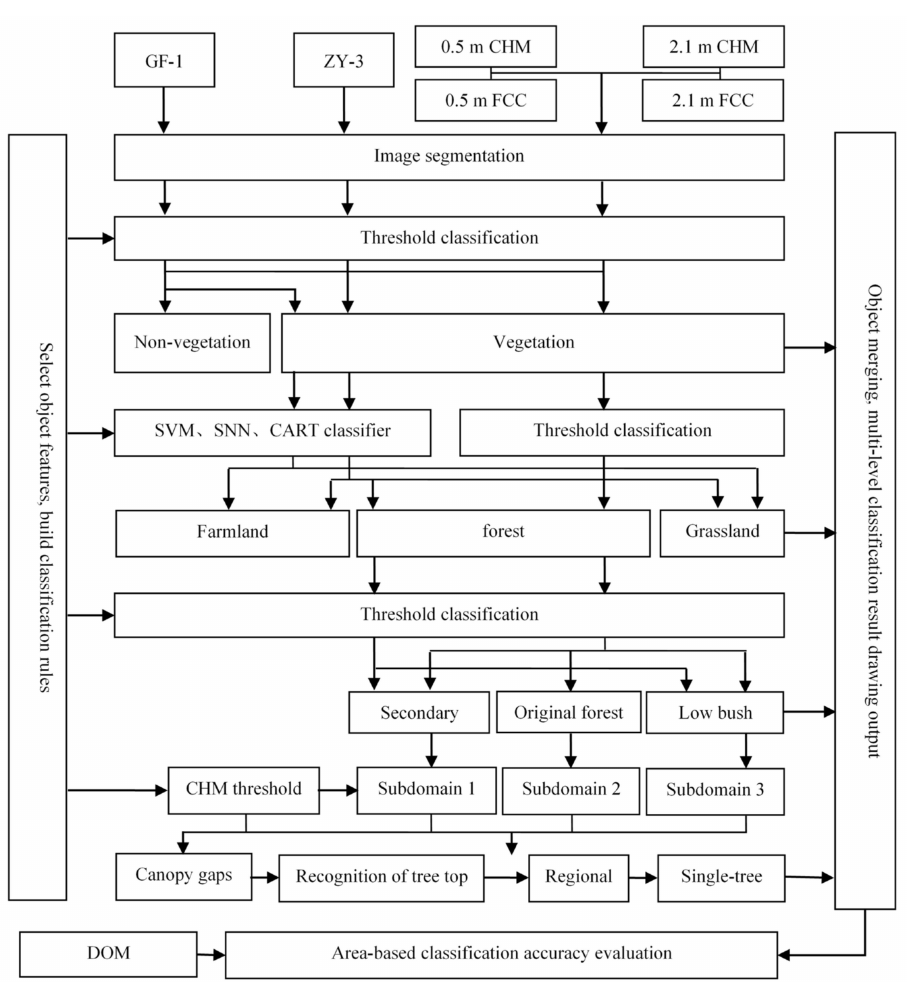
Figure 2. Layered object-oriented vegetation classification extraction technology